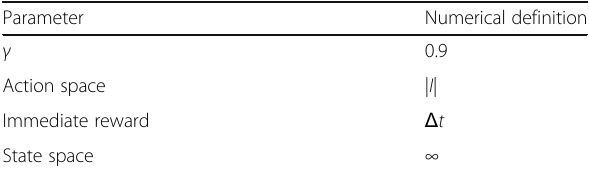
Table 1 Parameters of Markov decision process Parameter